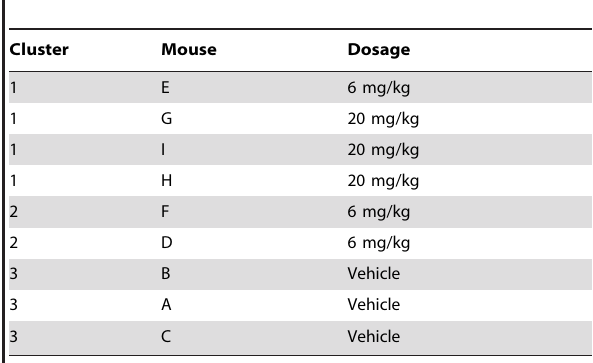
Table 3. Ordering of the tissue samples after a four-way factorization of rank